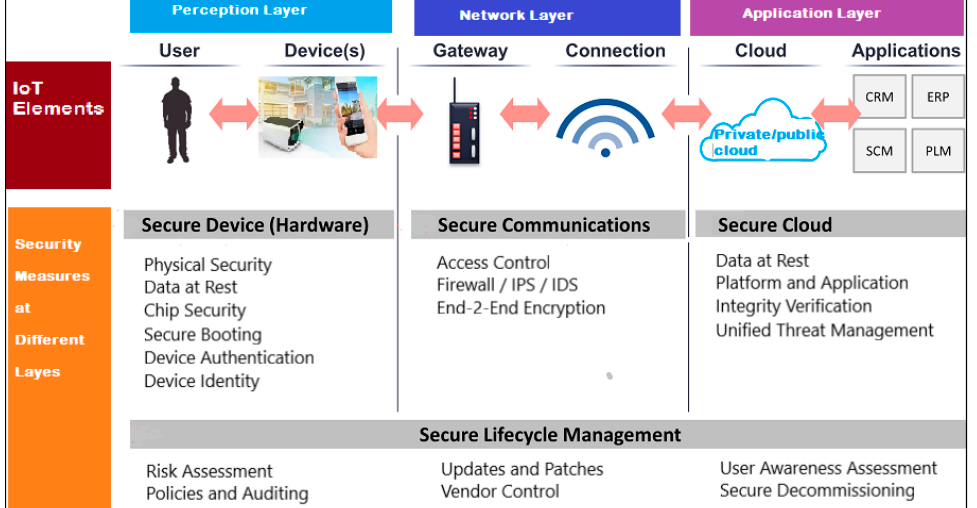
Table 3. Summary of security mechanisms.